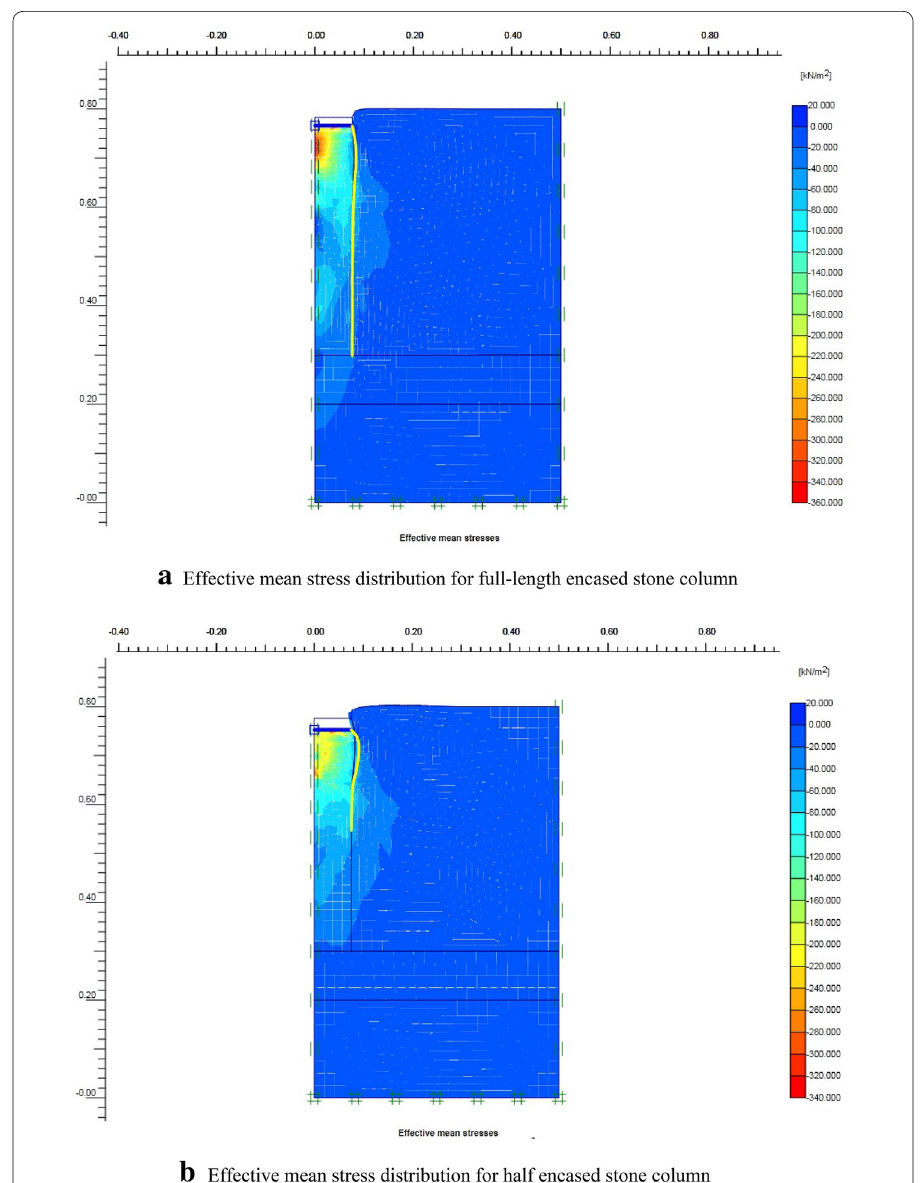
Fig. 10 Typical stress distributions for full-length and half-length encased stone